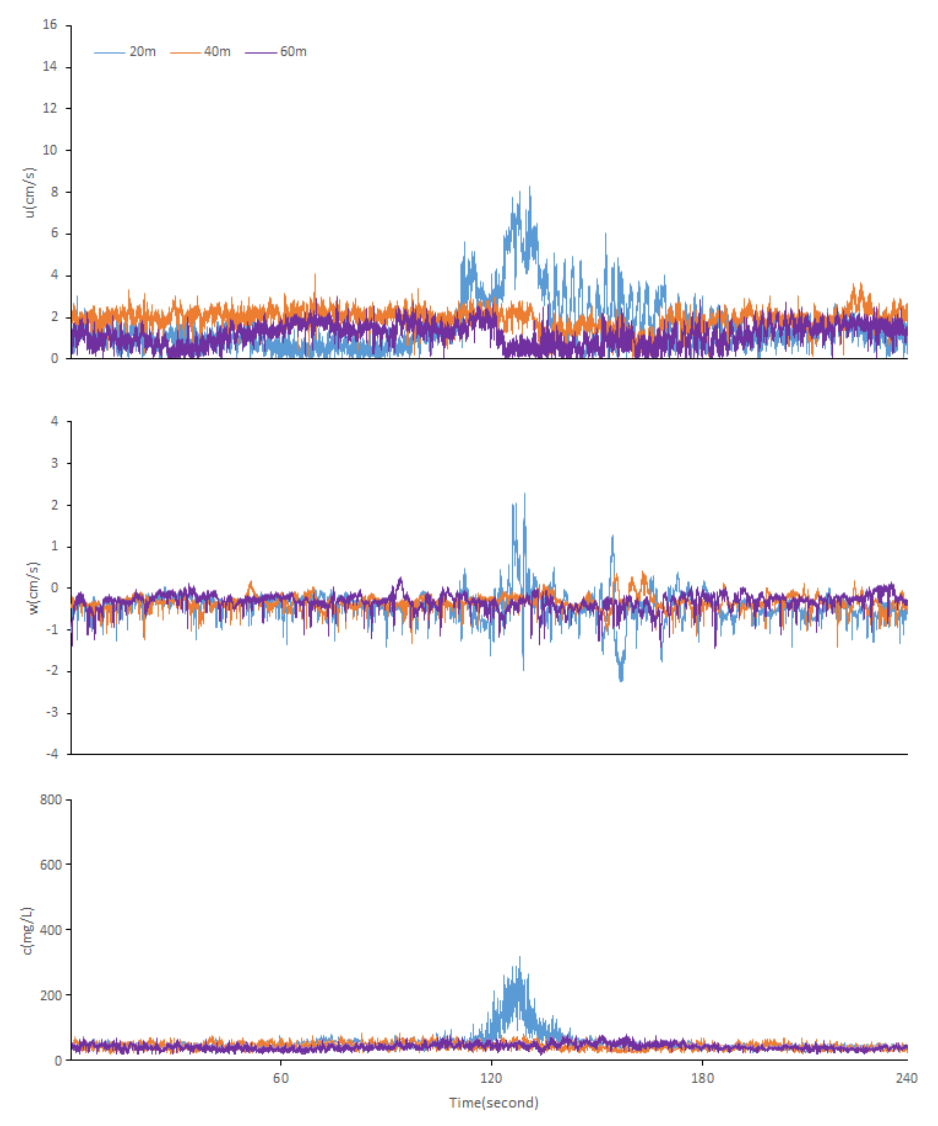
Figure 5. Time series records (no load): horizontal velocity ( u ), vertical velocity ( w ), and SSC ( c ) during the ship’s crossing.